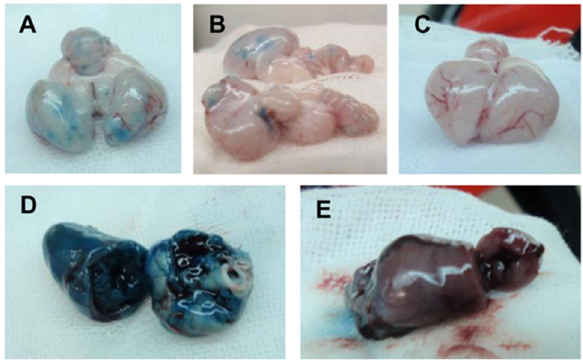
Figure 6. Extravasation of EB dye in the tissues of the chickens. Four days after infection, EB dye was intravenously injected into the chickens, and tissues were collected 3 h later. Photographs show brains of the chickens inoculated with Ty/ Italy ( A and B ) or Ck/Ibaraki ( C ) and hearts of the chickens inoculated with Ty/Italy ( D ) or Ck/Ibaraki ( E